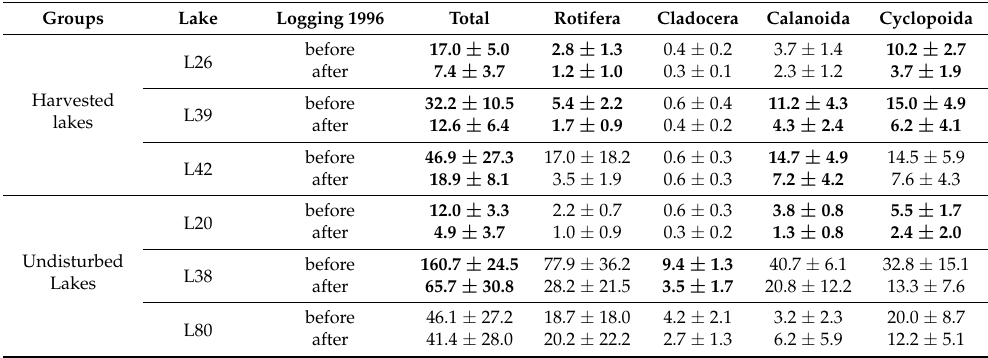
Table 2. Mean abundance (Ind. · L − 1 ± SD) of total zooplankton and taxonomic groups in the two groups of lakes (harvested vs undisturbed) before (1991–1995) and after (1996–2003) the 1996 initial clearcut logging. Values in bold indicated significant differences in zooplankton abundances before and after logging, both in harvested and undisturbed lakes (Mann-Whitney U test, p < 0.05).